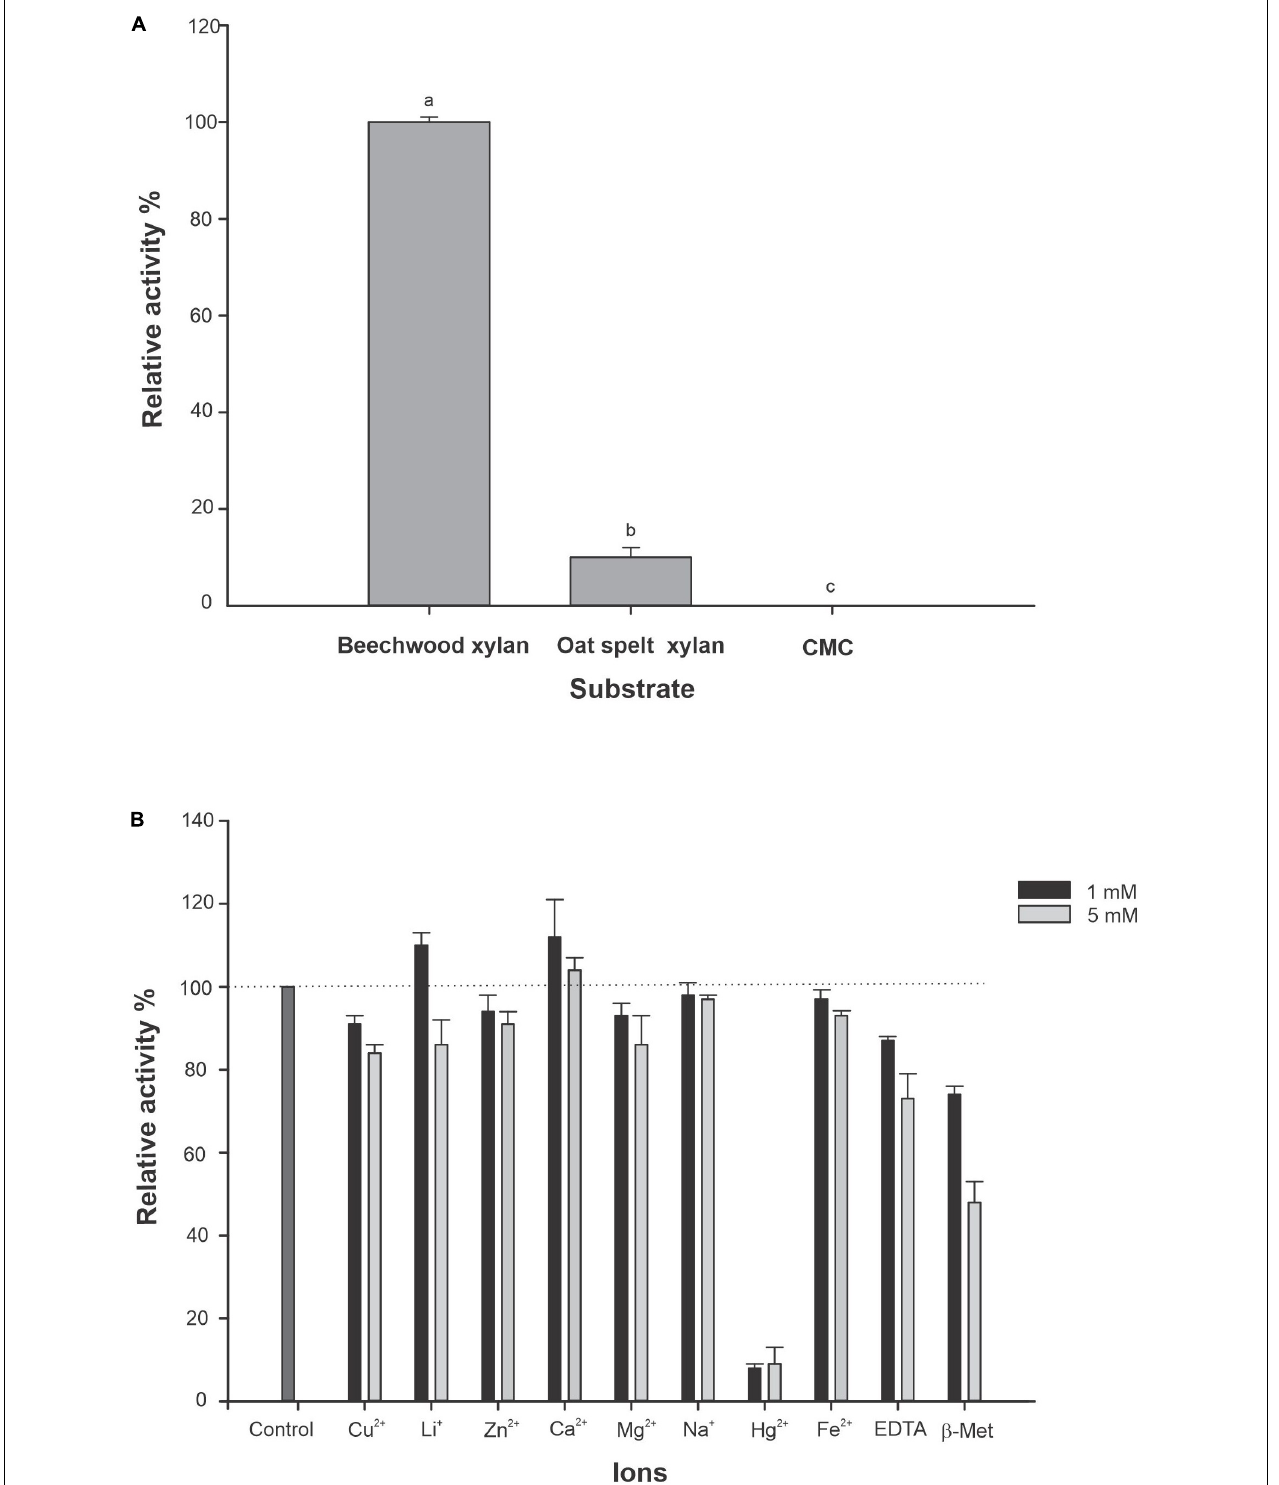
FIGURE 7 | Substrate affinity of R13 Fae and effect of metal ions, EDTA and 2- β -Met on enzyme activity ( n = 3). (A) The activity of R13 Fae was assayed using beechwood xylan, oat spelt xylan, and CMC at a final concentration of 1.0% (w/v) each in 50 mM citrate buffer pH 6.0 at 25 ◦ C. Different lower case letters indicate statistical significance ( p < 0.001). (B) Effect of metal ions, EDTA and β -Met on R13 Fae activity at two concentrations 1 and 5 mM. Enzyme was incubated in 1.0% (w/v) beechwood xylan in 50 mM citrate buffer pH 6.0 containing 1 and 5 mM of Cu 2 + , Li + , Zn 2 + , Ca 2 + , Mg 2 + , Na + , Hg 2 + , Fe 2 + , EDTA, and 2- β -Met at 25 ◦ C for 2